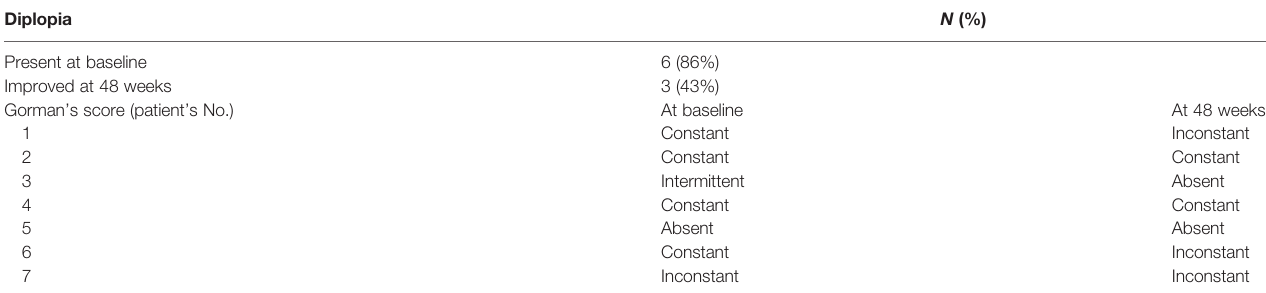
TABLE 2 | Diplopia according to the Gorman ’ s score in patients with active moderate-to-severe GO at baseline and after therapy in patients treated with rATG. Diplopia N (%) Present at baseline